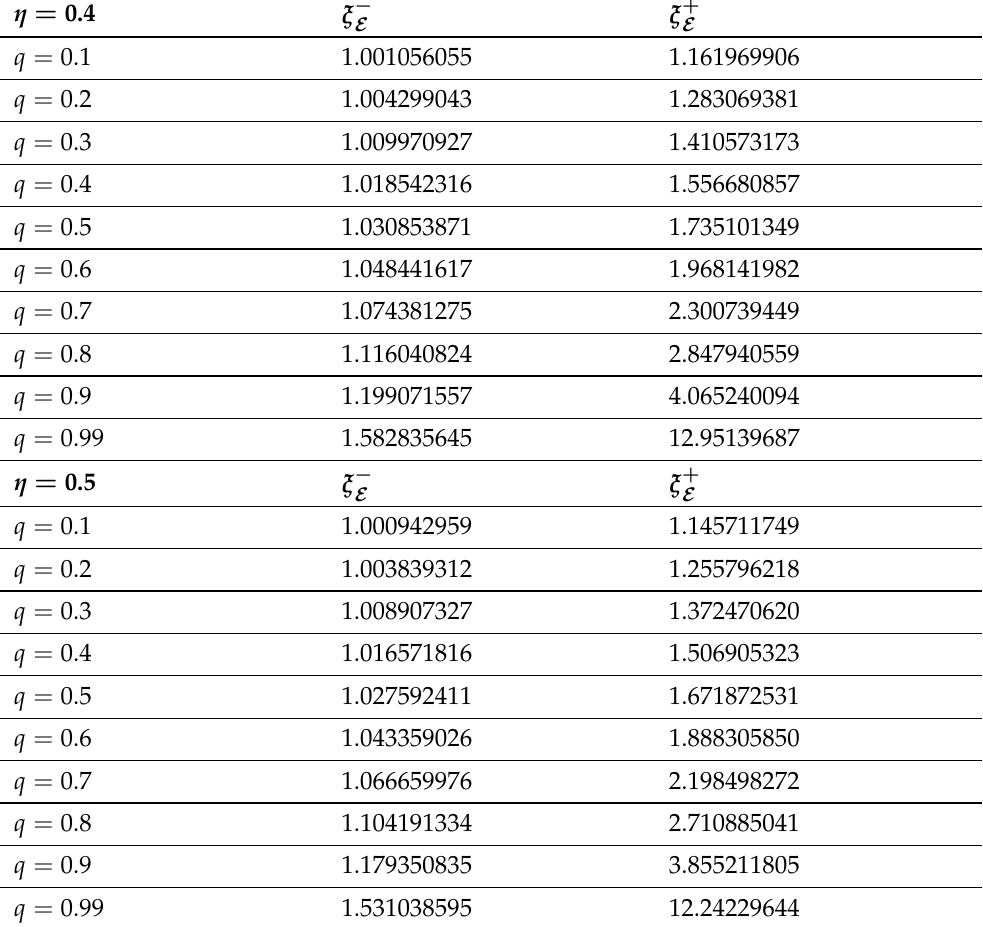
Table A2. Typical values of ξ ± E in prolate spheroidal coordinates for 0.1